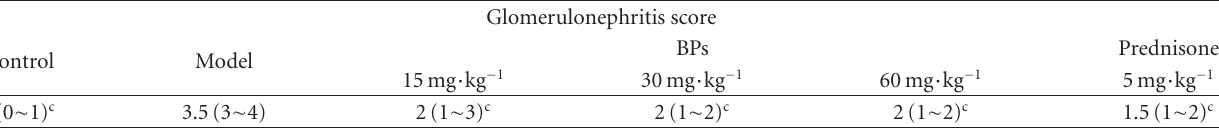
Table 2: E ff ect of BPs on glomerulonephritis scores of BALB/c and MRL-lpr mice. Glomerulonephritis